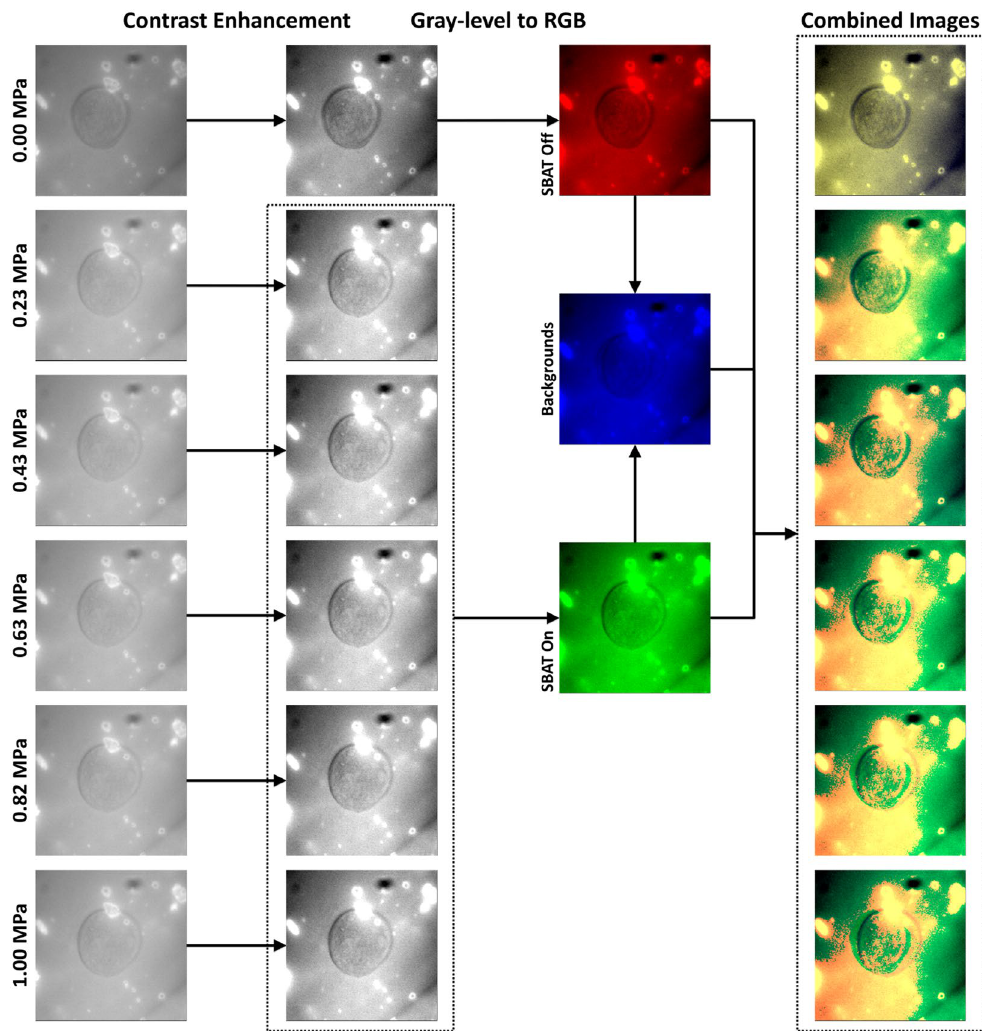
Figure 7. Proposed preprocessing procedures for emphasizing changes in cell boundaries. The first column shows cell photomicrographs captured at six pressure levels: 0.00, 0.23, 0.43, 0.63, 0.82, and 1.00 MPa. We enhance the contrast of the photomicrographs, as shown in the second column. Subsequently, we attempt to represent the deformation degrees with a single three-channel image. The photomicrographs at 0.00 MPa are placed in red channels, and the remaining images are used as green channels. The blue channels mark the background areas by averaging the photomicrographs at all pressure levels. The last column shows